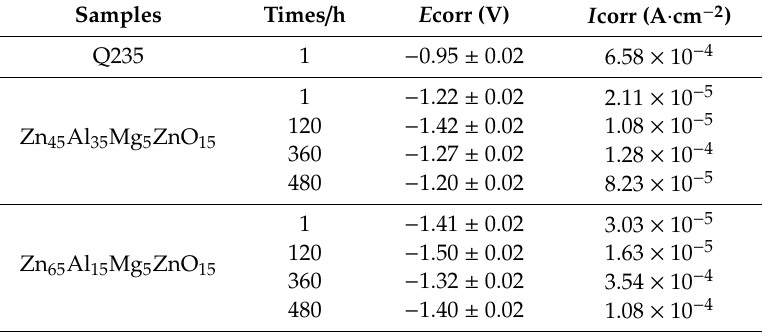
Figure 7. Polarization curves of two composite coatings at 1, 24, 120, 240, 360, and 480 h and polarization curves of matrix steel Q235: ( a ) polarization curves of Zn 45 Al 35 Mg 5 ZnO 15 at different times and ( b ) polarization curves of Zn 65 Al 15 Mg 5 ZnO 15 at different times.